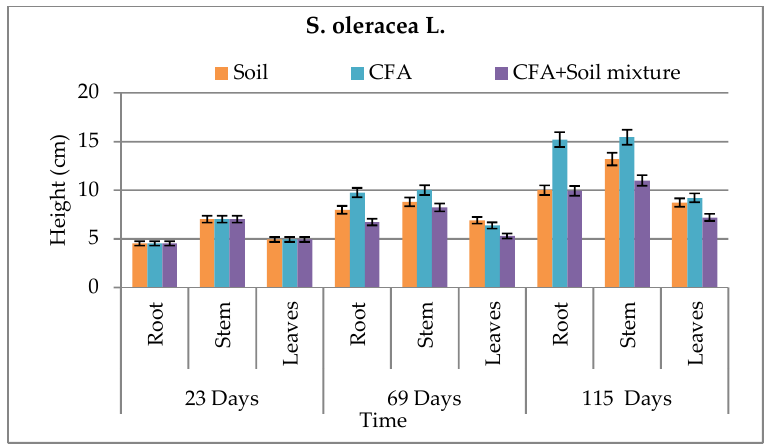
Figure 7. Growth performance of S. oleracea L. in all growth media. CFA: Coal-fly-ash.